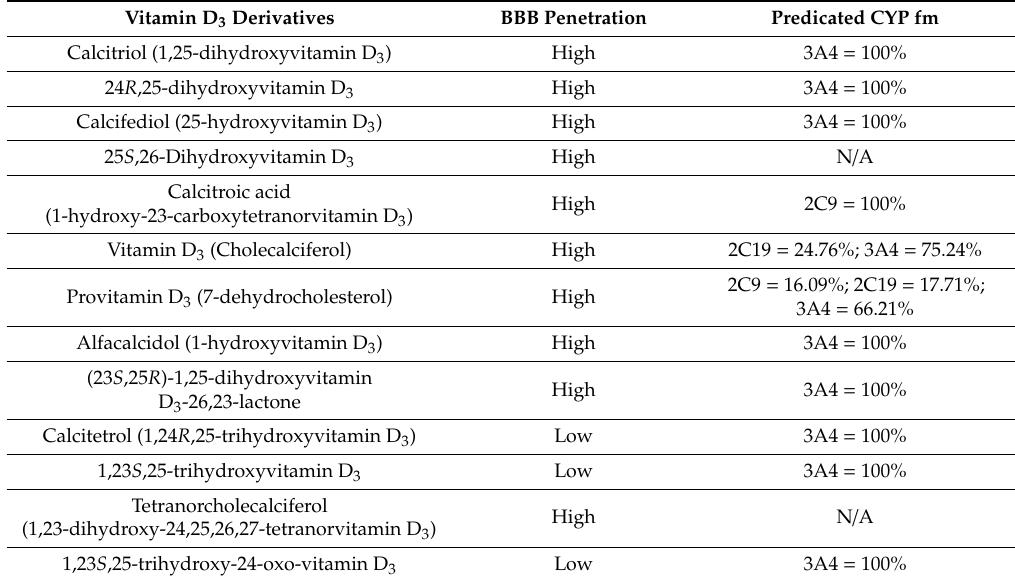
Table 2. Cytochrome P450 (CYP)-mediated predicted metabolism and ability to cross blood brain barrier (BBB) of provitamin D 3 (precursor of vitamin D 3 ) and vitamin D 3 derivatives determined by ADMET Predictor feature of the GastroPlus software. fm, fraction